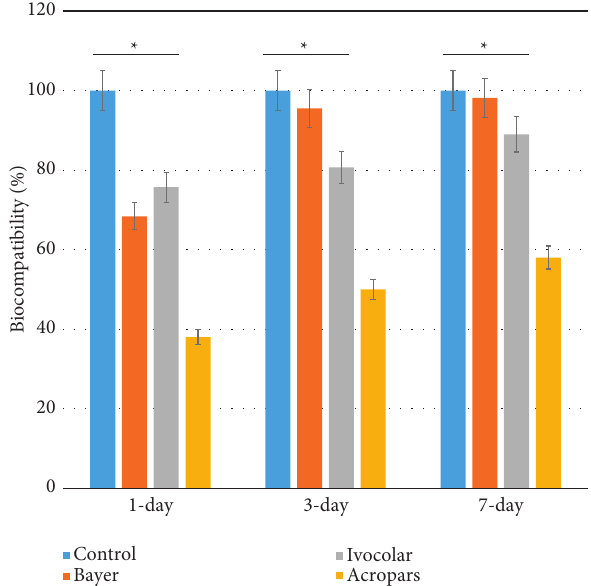
Figure 3: Amount of biocompatibility (%) according to follow-up intervals and categorized by acrylic resin